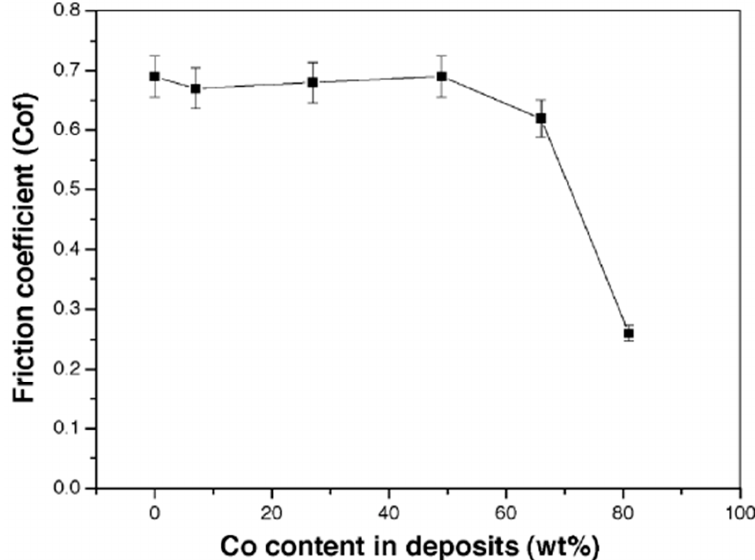
Figure 11. Friction coe ffi cient as function of Co content in the Ni–Co alloy deposit [20]. Reprinted from Applied Surface Science, 242, Liping Wang, Yan Gao, Qunji Xue, Huiwen Liu, Tao Xu, Microstructure